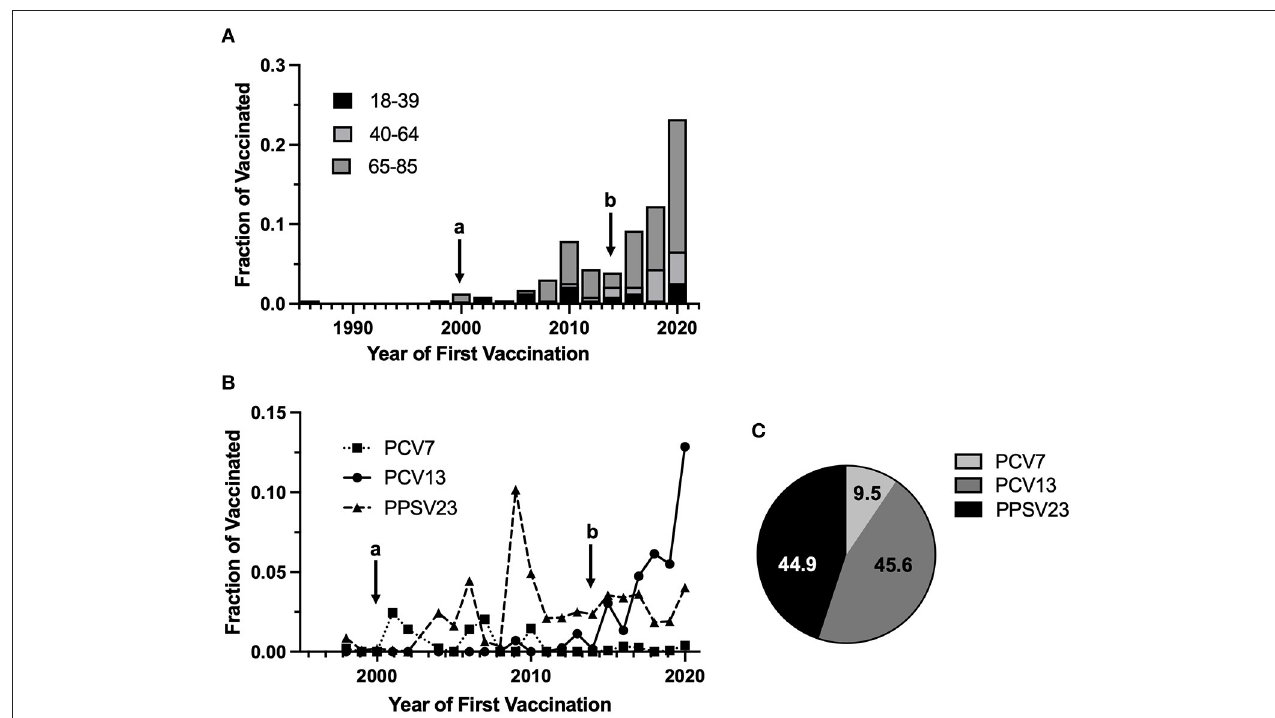
FIGURE 1 | Timing of pneumococcal vaccination and vaccine type usage. In (A,B) , point (a) denotes official recommendation of PPSV23 for adults 65 + and those at risk of severe disease in Switzerland; point (b) denotes an end to the official recommendation for vaccination of adults 65 + and a switch to PCV13 for those at risk of severe disease ( n = 230, 2 values were excluded because of missing date information in the vaccination record). Note that 2020 was a partial study year. (A) Year of First Vaccination: The fraction of individuals receiving at least one pneumococcal vaccine dose which received their first pneumococcal vaccination in a given year, by age group. (B) Vaccine type usage by year: The fraction of first pneumococcal vaccine doses in a given year, by vaccine type. (C) Total pneumococcal vaccine doses by type: The percentage of total pneumococcal vaccine doses received by individuals, by vaccine type ( n = 297 doses from 230 individuals, 11 values were excluded because of missing vaccine type information in the vaccination